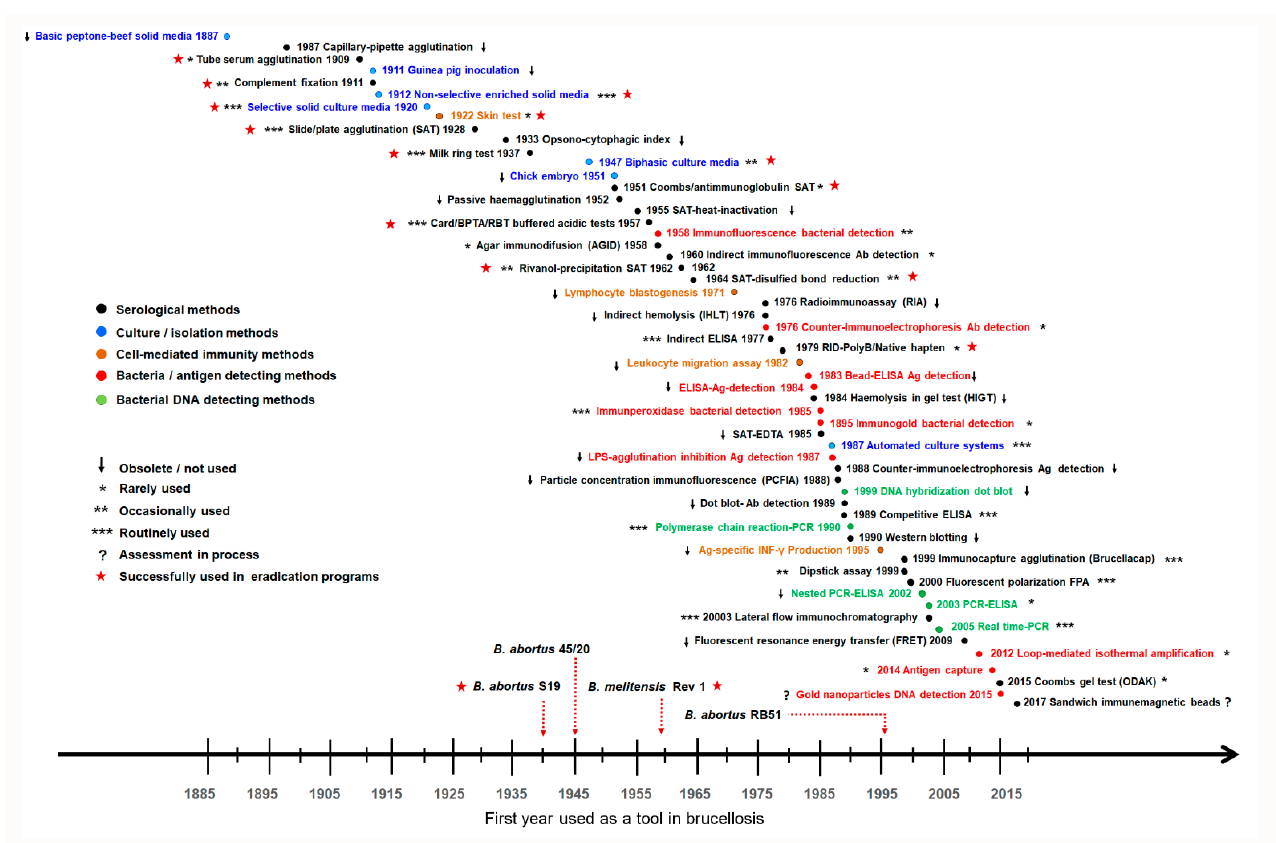
(Figure 3). In general, the brucellosis diagnostic assays are divided into five distinct groups: bacterial isolation–identification, antigen detection, DNA detection, assessment of the antibody response, and assessment of cell-mediated immune response. While the first three are direct procedures, the last two are indirect methods. Despite this enormous diversity, the commonly used diagnostic assays can be counted with both hands.